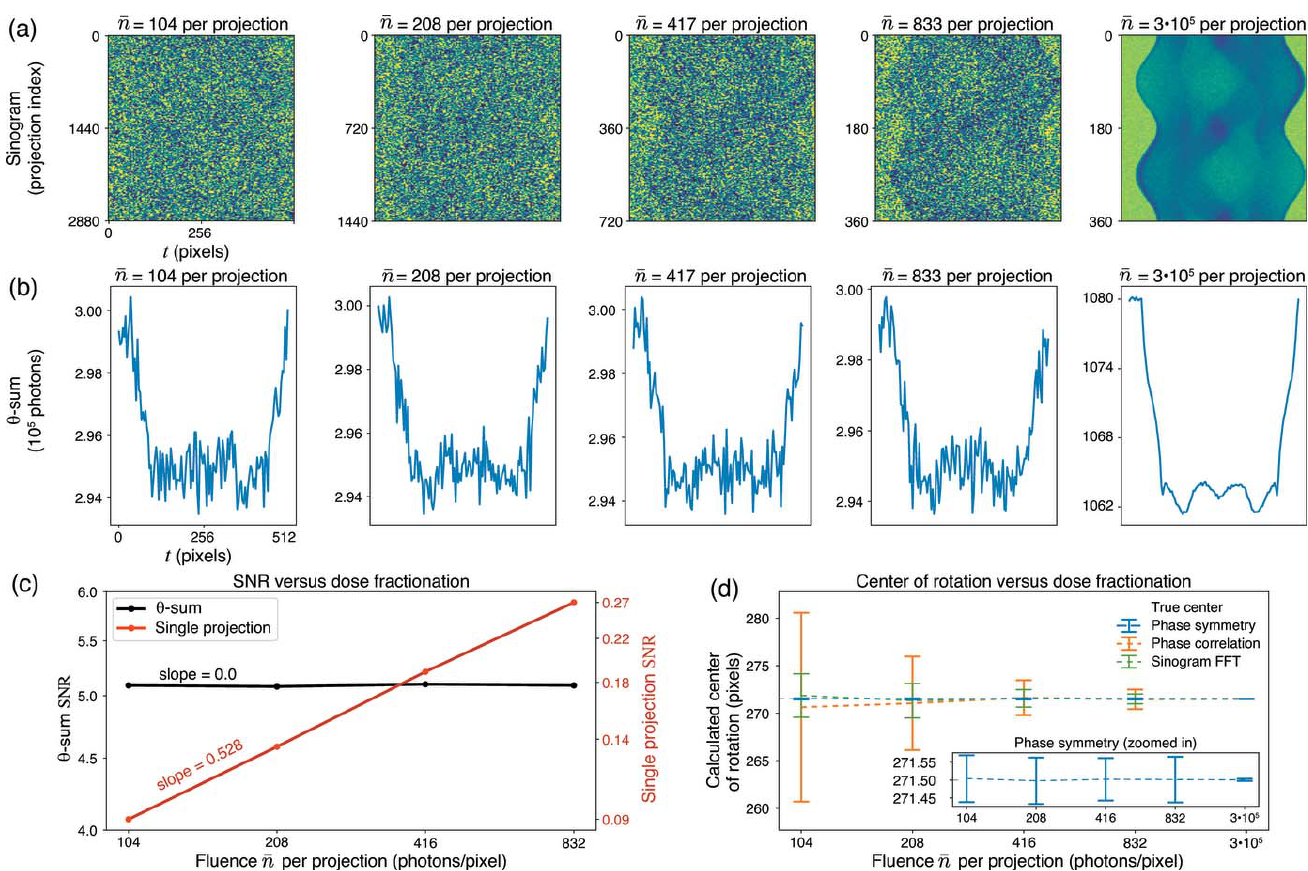
Figure 6 Center of rotation (COR) demonstration on dose fractionated, 360 (cid:2) , simulated data. A simulated low-contrast 3D Shepp–Logan phantom was generated to which Poisson noise was applied with a cumulative fluence of 300000 photons per pixel. As this fluence is divided into N (cid:2) = 360, 720, 1440, and 2880 projections (with (cid:3) nn = 833, 417, 208, and 104 photons per pixel per projection, respectively), one can see that individual projections become increasingly noisy in a subset of projections shown in a sinogram ( a ) and also in the single projection SNR ( c ). Since the same cumulative fluence was used, the (cid:2) -sums shown in ( b ) and the (cid:2) -sum SNR shown in ( c ) are the same no matter the number of projections N (cid:2) used. [A sinogram with (cid:3) nn = 300000 photons per pixel per projection is also shown on the right in ( a ) and ( b ), showing no visible Poisson noise.] In spite of the very low SNR of individual projections (which scales as (cid:3) nn 1 = 2 as expected) shown in ( c ), the phase symmetry method accurately finds the center of rotation with low variance as shown in ( d ). The COR error bars in ( d ) represent the standard deviation in COR results from 100 different instances of Poisson noise at the indicated fluence per